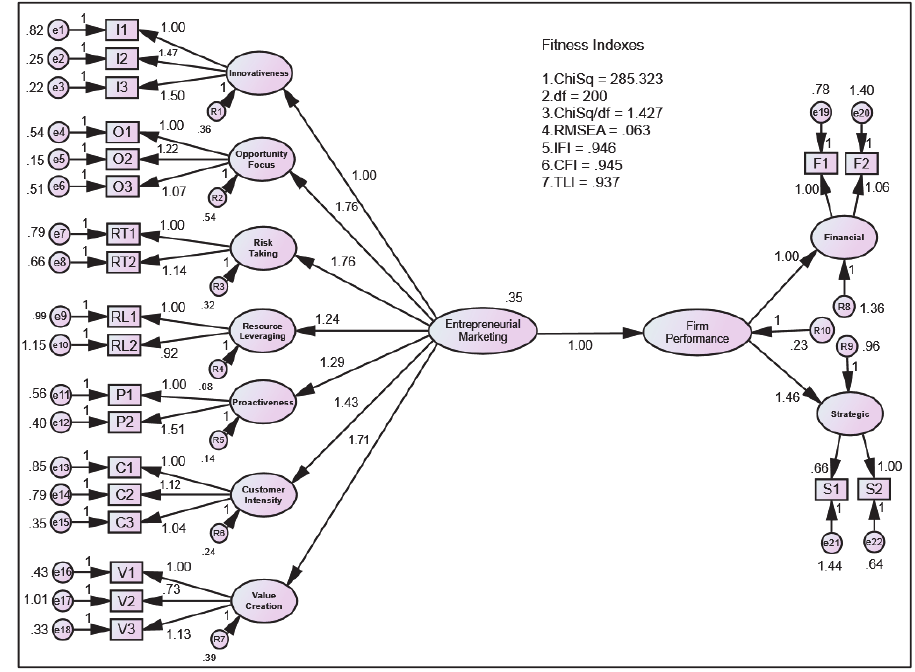
Fig. 7. Female Group: Constrained Model Output